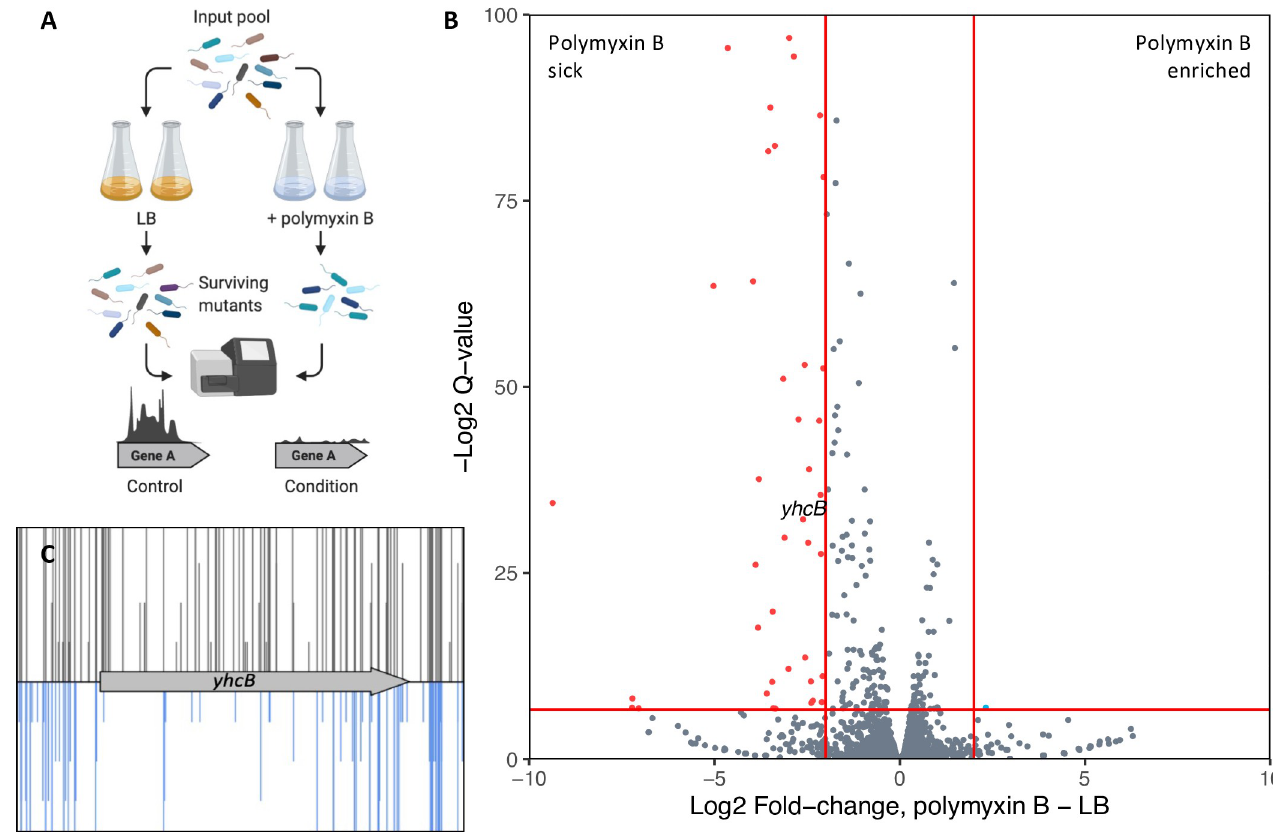
Fig 1. Screening the E . coli BW25113 transposon library in sub-inhibitory concentrations of polymyxin B. (A) Schematic showing the TIS experiment for identification of polymyxin B-sensitive mutants, created with BioRender.com (B) Volcano plot of the fold-change in mapped reads between conditions, calculated using BioTraDIS. Datapoints in red correspond with genes with > 2-fold decrease in reads in the polymyxin B dataset relative to the LB outgrowth dataset, and with a Q-value > 0.01 (red horizontal line). A label for the yhcB datapoint has been added above the point for clarity. (C) Image of the yhcB insertion data following outgrowth in LB only (grey, above) or in LB supplemented with polymyxin B (blue, below). The transposon insertion position along the gene is marked by a vertical line, with the vertical line size corresponding with read depth.